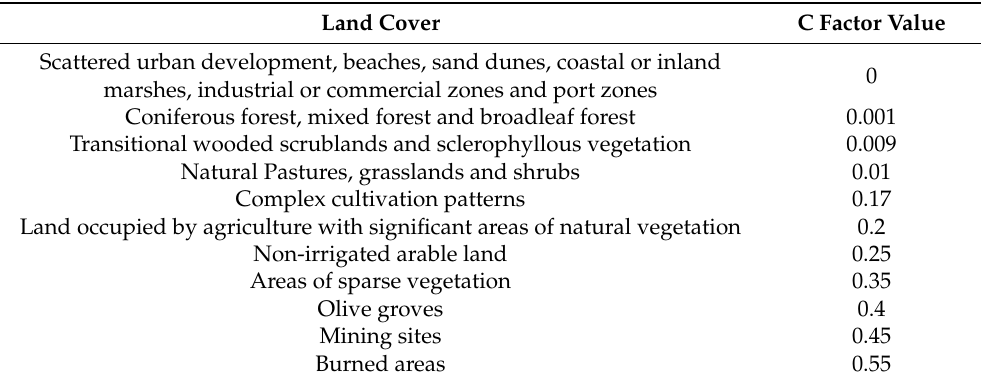
Table 3. Cropping management factor (C) values for the land cover classes of the study area. Land Cover C Factor Value Scattered urban development, beaches, sand dunes, coastal or inland 0 marshes, industrial or commercial zones and port zones Coniferous forest, mixed forest and broadleaf forest 0.001 Transitional wooded scrublands and sclerophyllous vegetation 0.009 Natural Pastures, grasslands and shrubs 0.01 Complex cultivation patterns 0.17 Land occupied by agriculture with significant areas of natural vegetation 0.2 Non-irrigated arable land 0.25 Areas of sparse vegetation 0.35 Olive groves 0.4 Mining sites 0.45 Burned areas